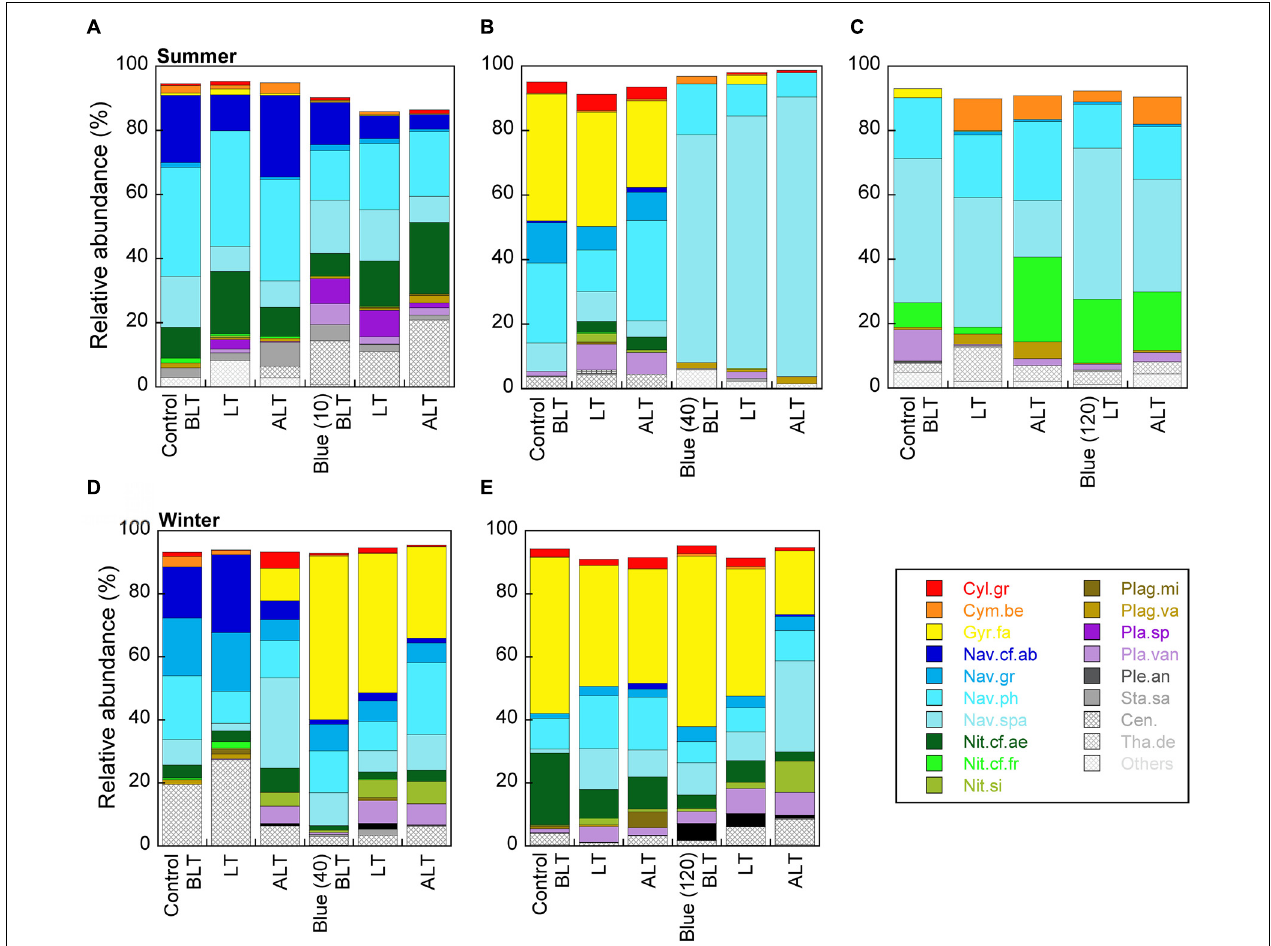
FIGURE 6 | Cumulative relative abundance of the 19 diatom species found at least once > 5% of the total relative MPB abundance in the upper layer (0–250 µ m) of muddy sediment for the three timings of the in situ low tide at the sampling site (BLT-3 h before low tide, LT-low tide timing, ALT-3 h after low tide) and for two seasons and different light conditions: (A–C) summer blue (465 nm) light treatment with three increasing light intensities: (A) 10, (B) 40, and (C) 120 µ mol photons m − 2 s − 1 with their respective control (24-h natural photoperiod) light conditions; (D,E) winter blue light treatment with two light intensities: (D) 40 and (E) 120 µ mol photons m − 2 s − 1 with their respective control light conditions. The full list of species with their full names is found in Supplementary Table S5. A zoom of winter and summer 40 µ mol photons m − 2 s − 1 blue light treatments with focus on Navicula spartinetensis and Gyrosigma fasciola is shown in Supplementary Figure S10